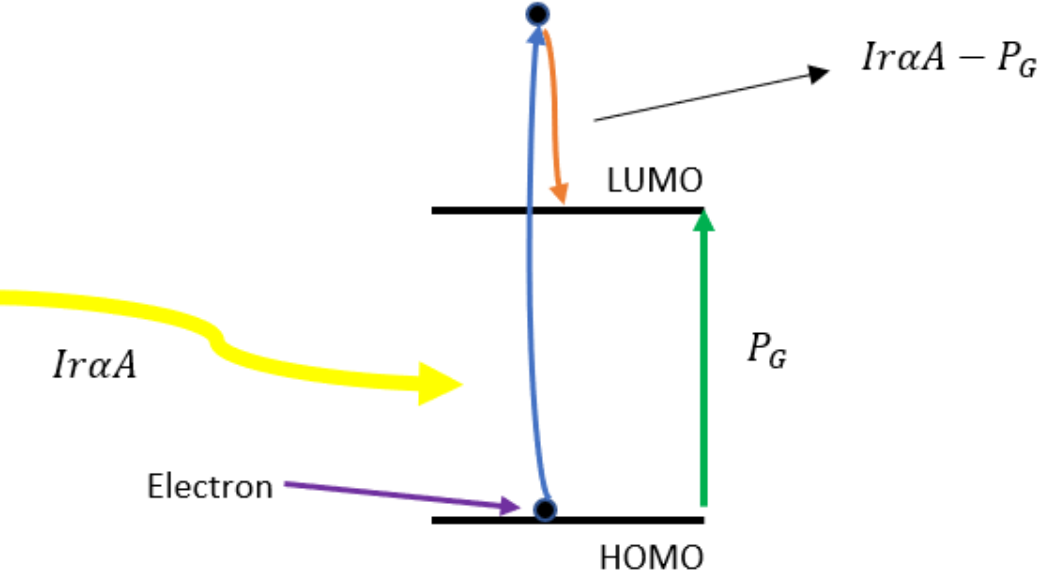
Figure 3. The schematic diagram of heat generation due to thermalization. An electron from HOMO is excited to higher energy than LUMO and then relaxes to LUMO by releasing the excess power Ir α A . Some of the electrons and holes generated due to the absorbed solar power, P G , may recombine non-radiatively and generate the thermal power denoted by P Rec , and some may generate thermal power P B by moving to lower energy due to energy off-sets while transferring towards their respective electrodes. Thus, P Rec , the total thermal power generated due to the non-radiative recombination of the photo-generated electron and hole pairs, can be expressed as P Rec [28]: